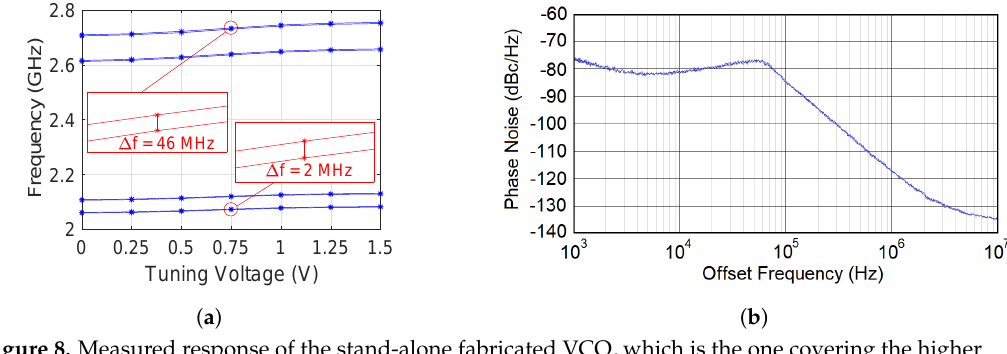
Figure 8. Measured response of the stand-alone fabricated VCO, which is the one covering the higher frequency range. ( a ) Tuning range and coarse frequency step and ( b ) phase noise at the highest frequency of 2.7